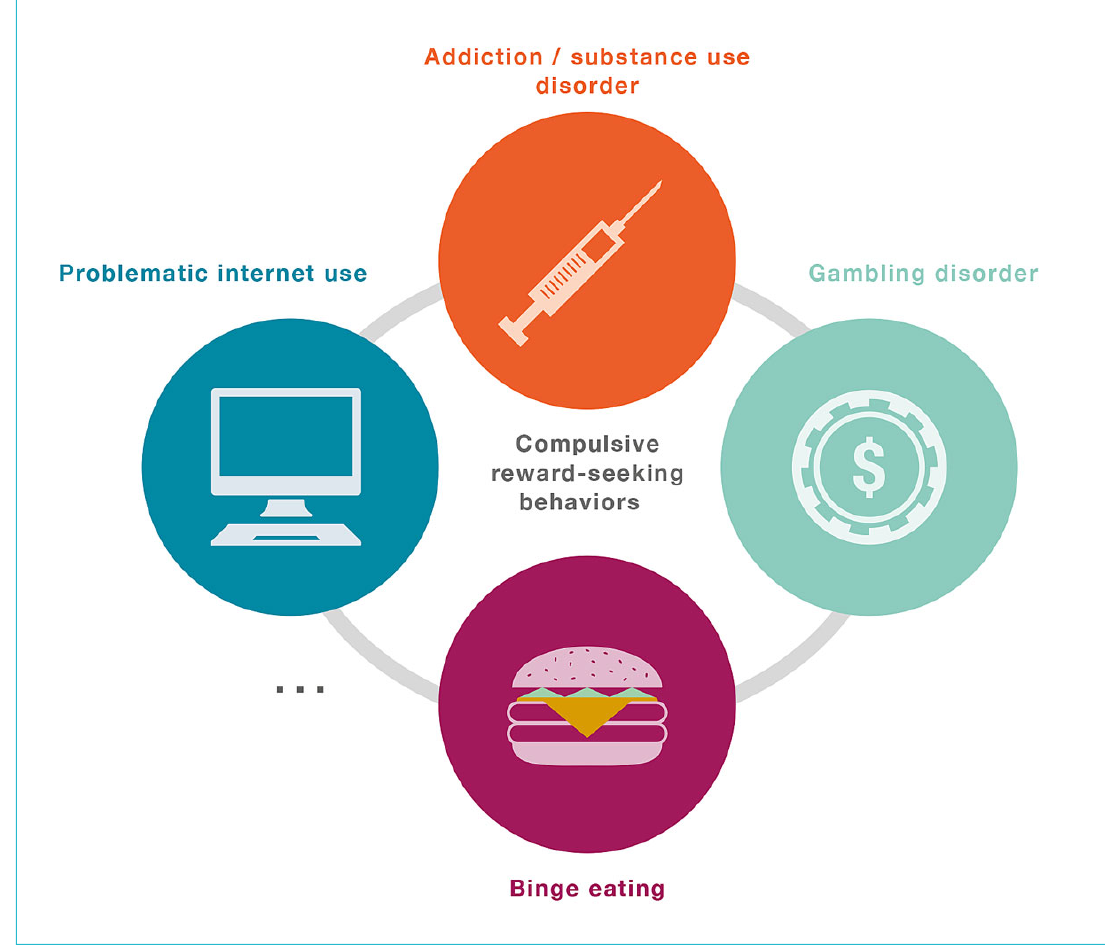
Figure 1: Illustration of compulsive reward-seeking behaviours as a trans-diagnostic dimension. Compulsive reward-seeking behav- iours are implicated in several psychiatric disorders such as substance addiction, binge eating, and various kinds of behavioural addictions (e.g., gambling, internet, shopping). In this review, we focus on their role in substance addiction (or substance use disorder), particularly in stress-induced